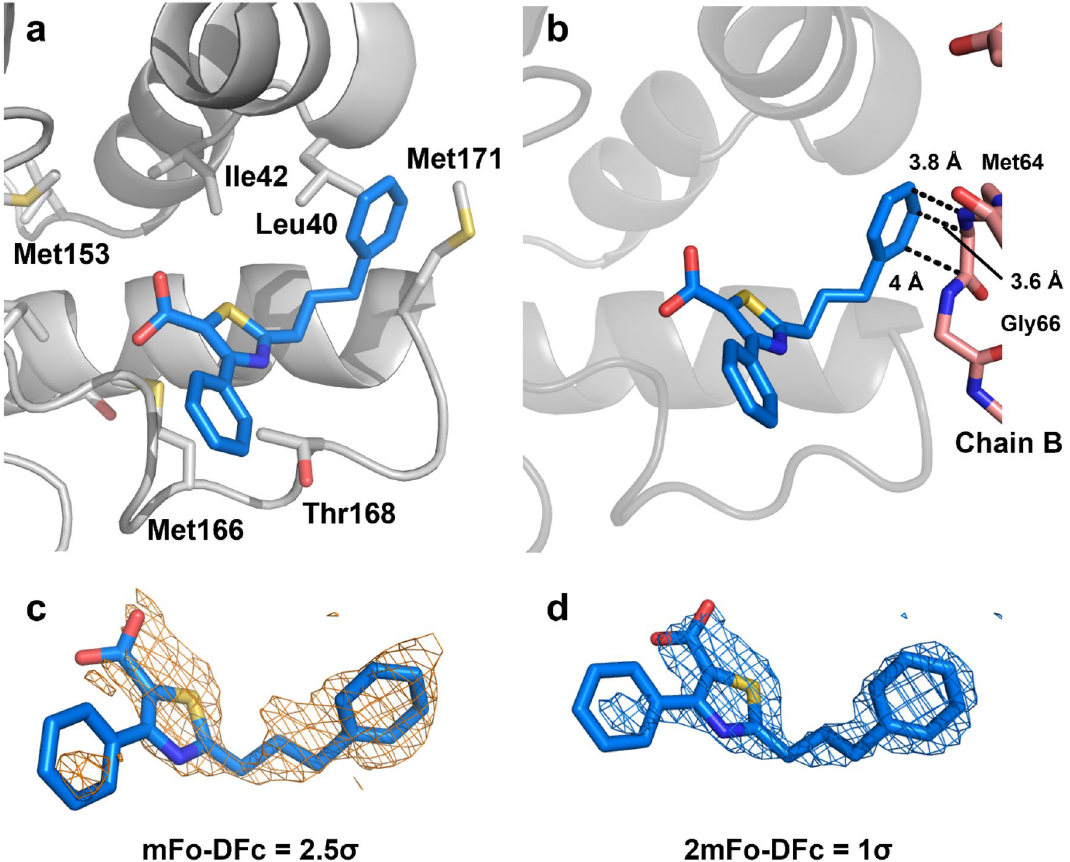
Figure 3. X-ray structure of Ec DsbA–phenylthiazole 1 complex at 2.0 Å resolution. ( a ) Ligand is shown in blue sticks and the protein is in grey cartoon. Several side chain residues of Ec DsbA at the binding site are shown in sticks. Only the binding site region is shown for clarity. ( b ) Crystal contacts between the heavy atoms of Chain B (depicted in salmon sticks) and the ligand are shown as dotted black lines. ( c ) Simulated annealing omit σ A - weighted mFo-DFc electron density map of phenylthiazole 1 contoured at 2.5σ and displayed in yellow mesh. ( d ) σ